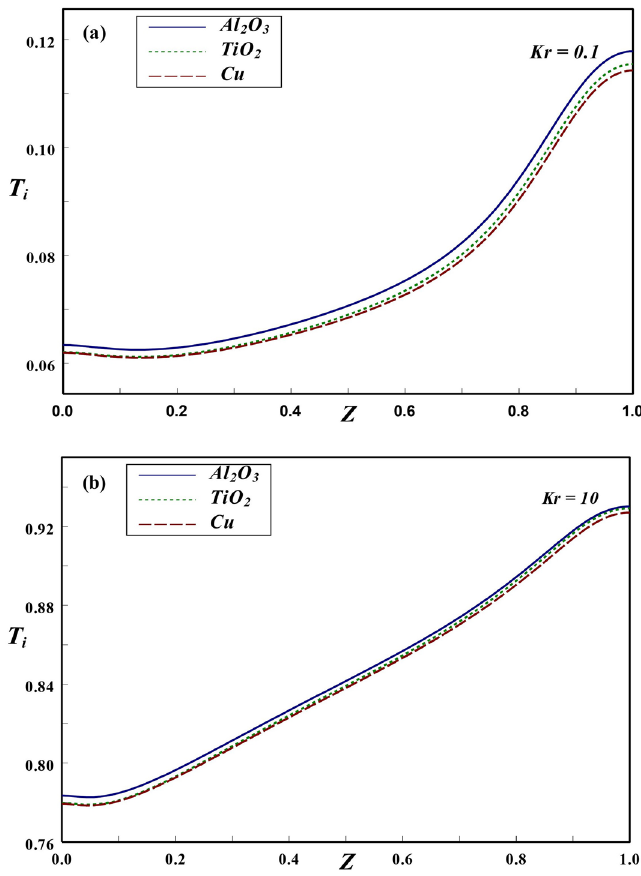
Figure 14. Axial variation of interface temperature with ( a ) Kr = 0.1 and ( b ) Kr = 10